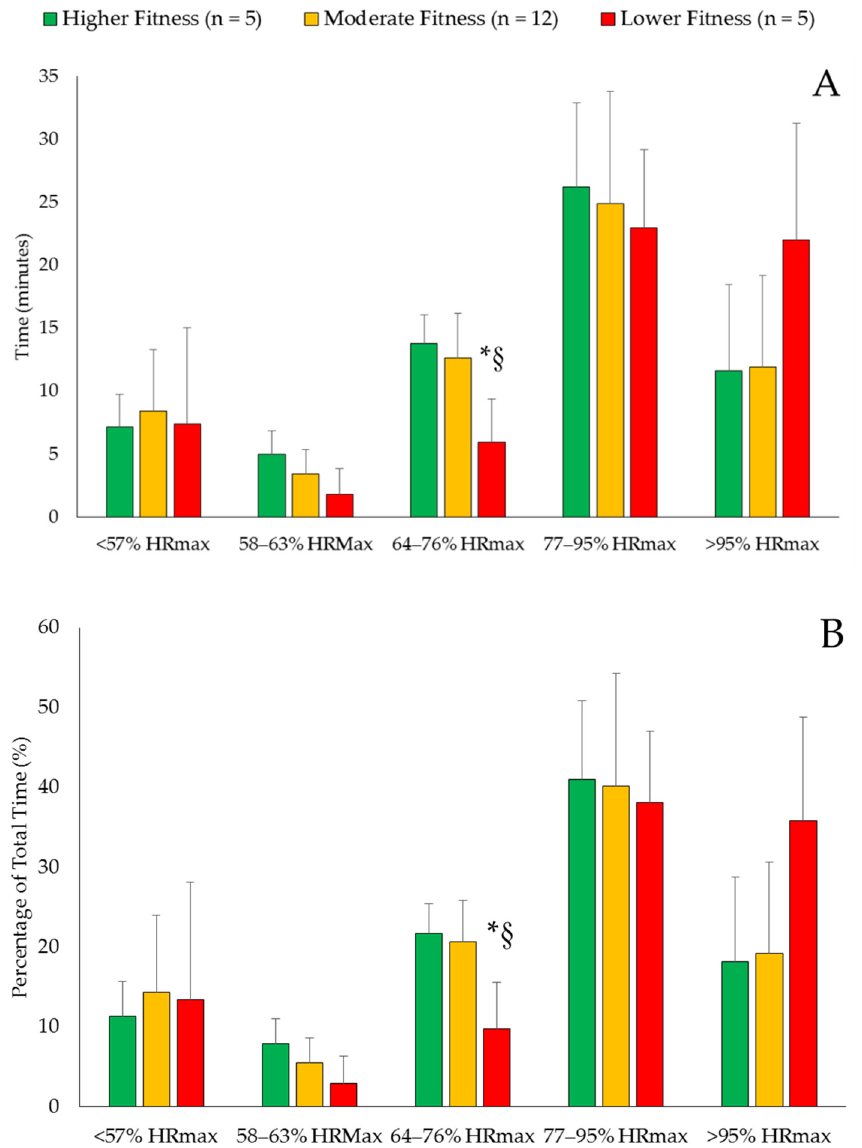
Figure 2. Time spent ( A ) and percentage of total time spent ( B ) in heart rate (HR) intensity zones defined by the American College of Sports Medicine [44] for higher fitness, moderate fitness, and lower fitness custody assistant recruits during circuit training session two. * Significantly ( p < 0.05) different from the HF group. § Significantly ( p < 0.05) different from the MF group.